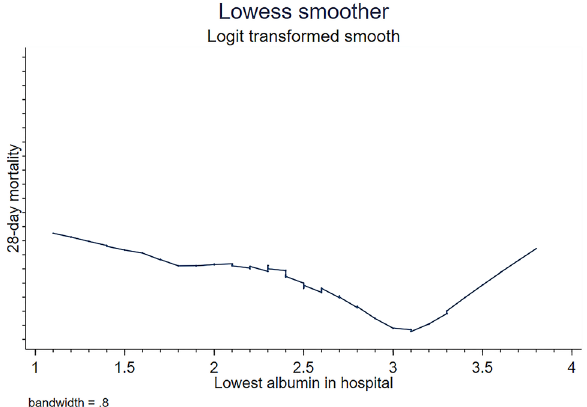
Figure 2. The Lowess smoothing technique shows the relationship between the lowest in-patient serum albumin level and the 28-day mortality